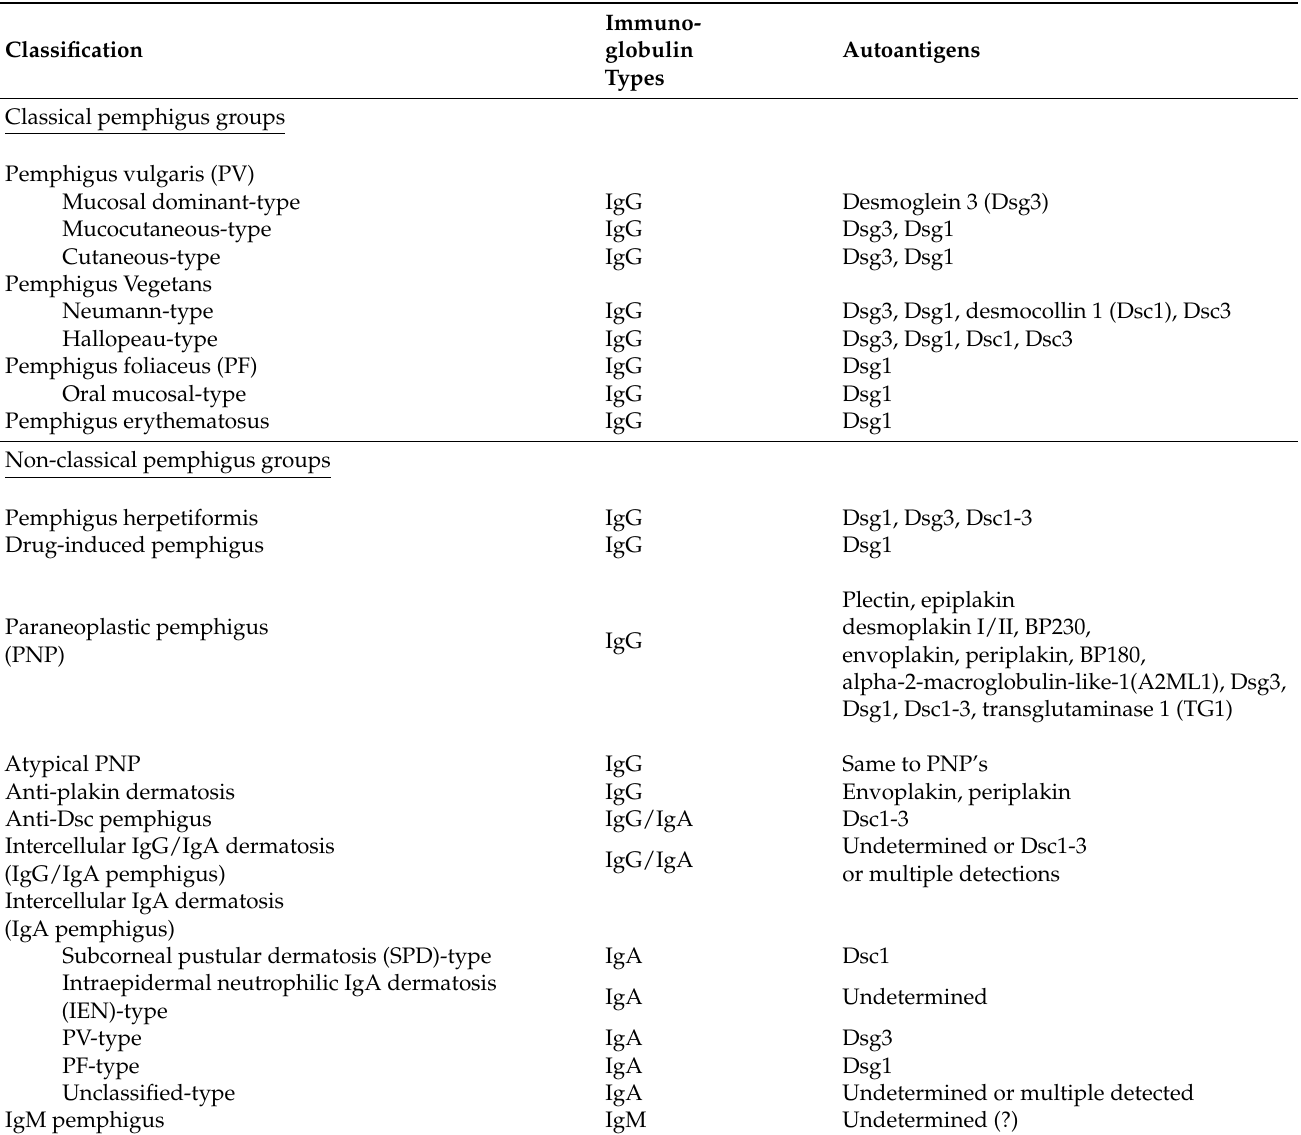
Table 1. Classification, immunoglobulin types and autoantigens of pemphigus